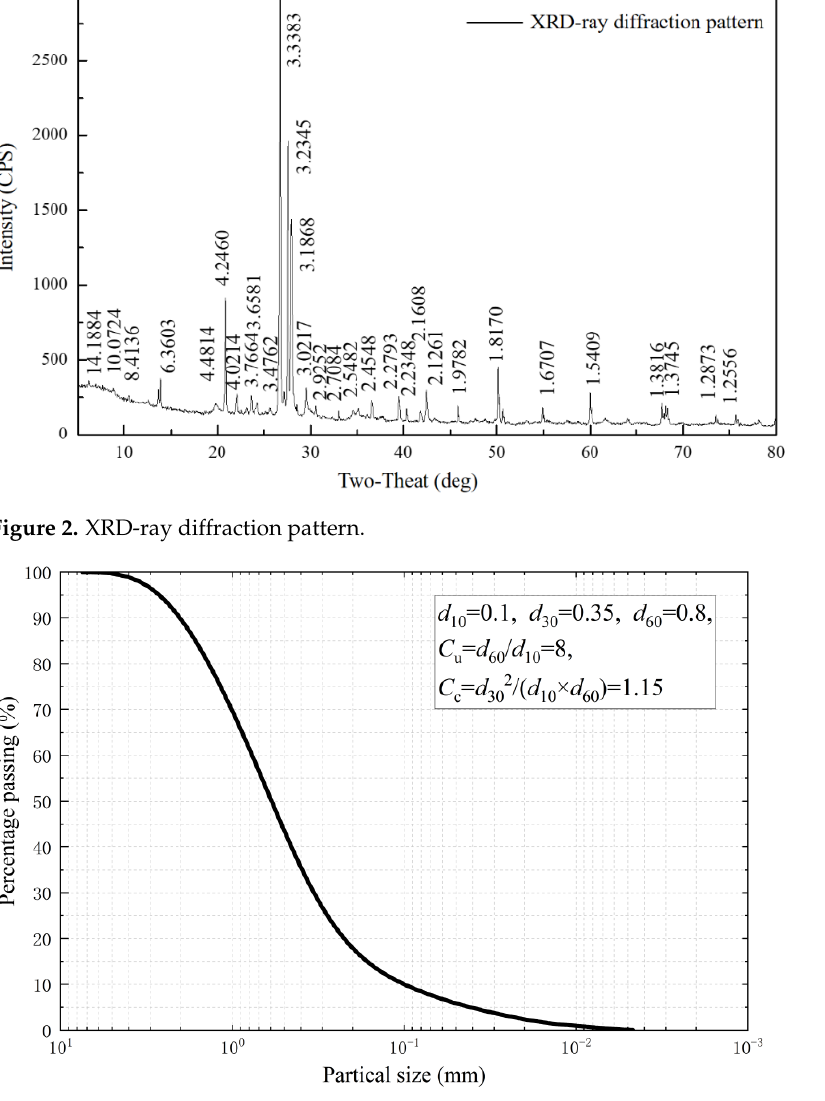
Figure 3. Grain size distribution of natural saline soil. Table 2. Physical properties of the natural saline